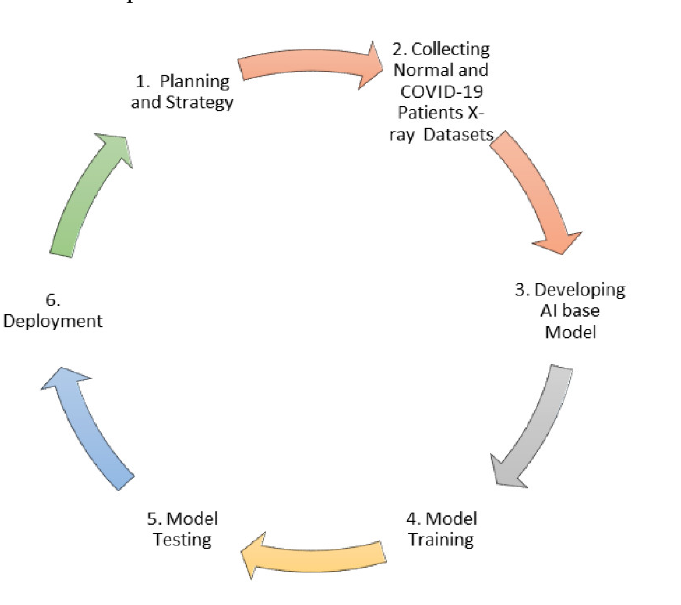
Figure 3. Implementation flow of data collection and